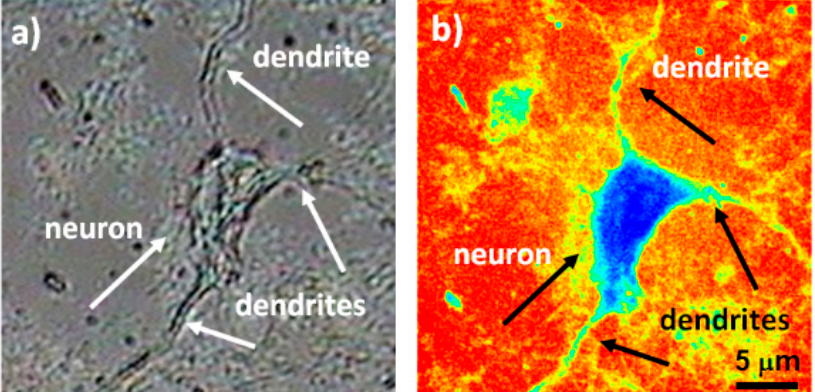
Figure 21. Comparison of the mouse hippocampal neuron acquired ( a ) with an optical microscope (40× objective, 400×) and ( b ) SXR microscope (in false colors), showing a single neuron with dendrites branching out. Image acquired after 200 SXR pulses, 20 s exposure. Figure ( a ) from